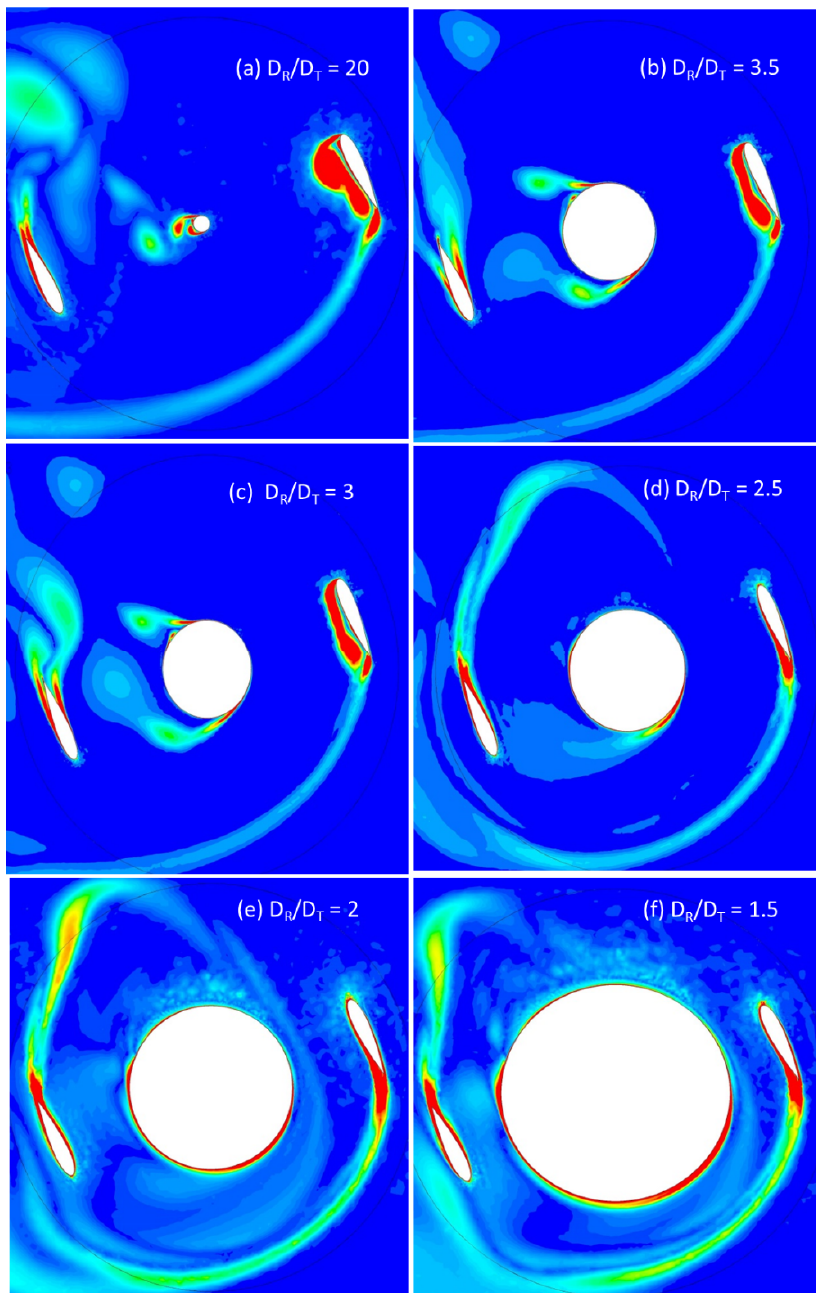
Figure 12. Vorticity contours (S −1 ) for AHDT at β = 30°.